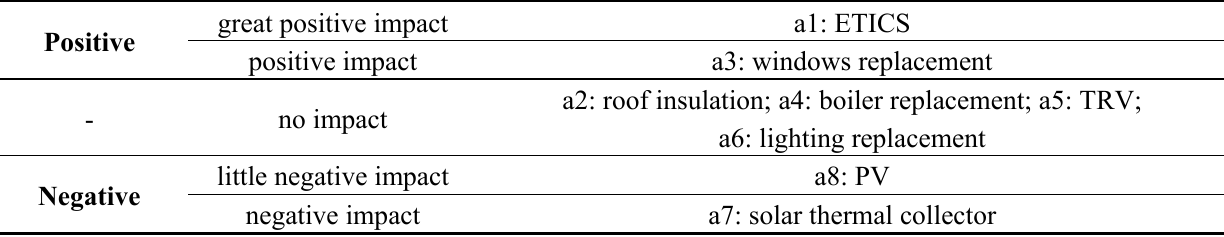
Table 13. Architectural impact criterion.